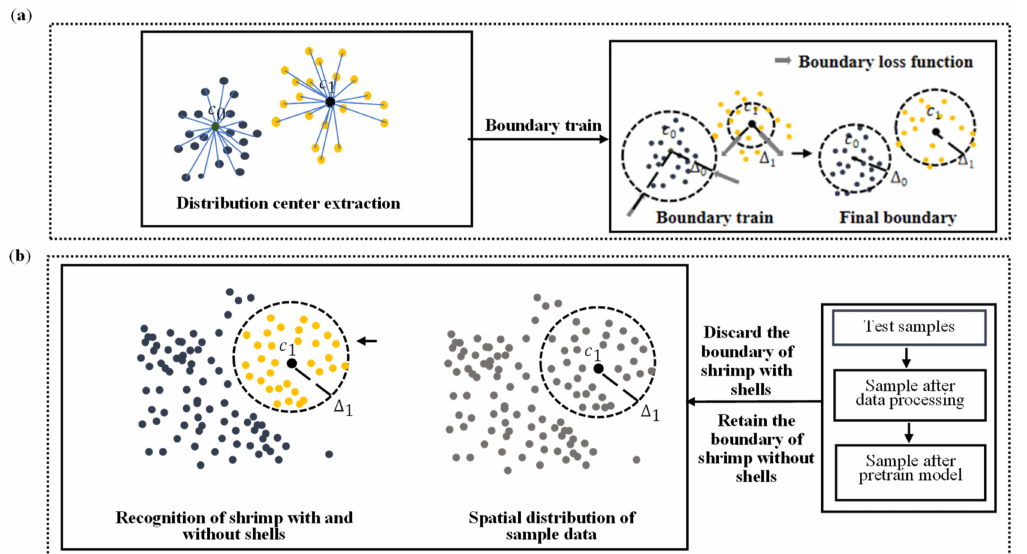
Figure 6. Boundary training and recognition schematic. ( a ) The boundary training schematic; ( b ) the recognition